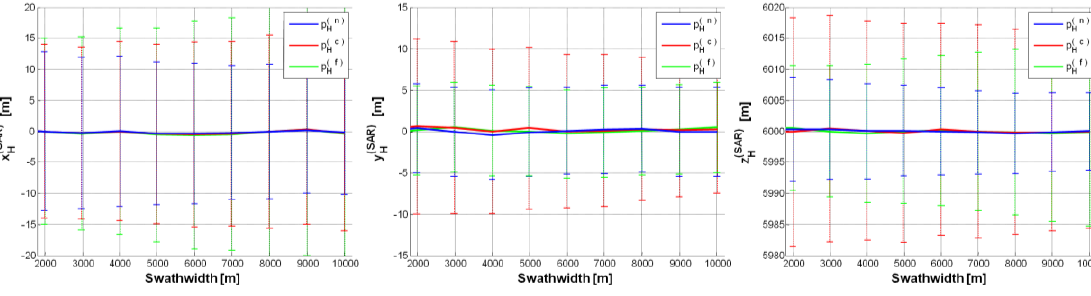
Figure 5. SAR position estimates (CS#2 in Table 2) based on a single GCP ( ( ) n